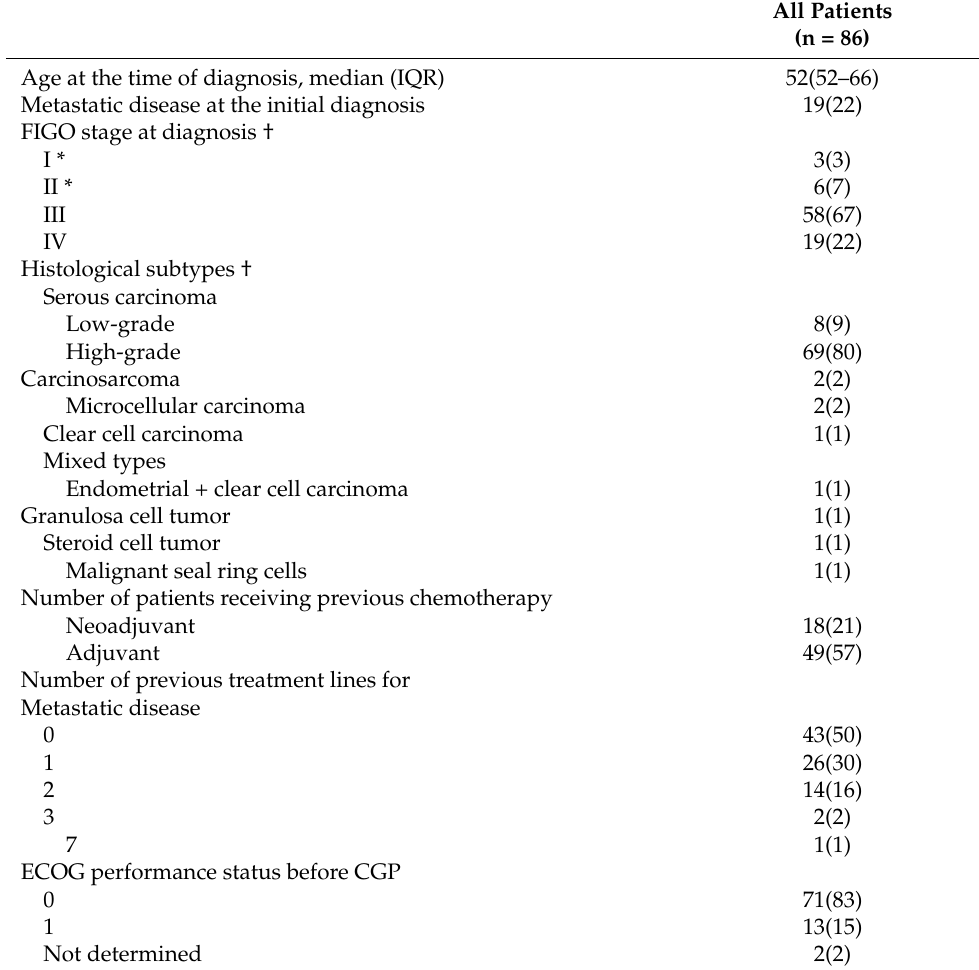
Table 1. Characteristics of patients before comprehensive genomic